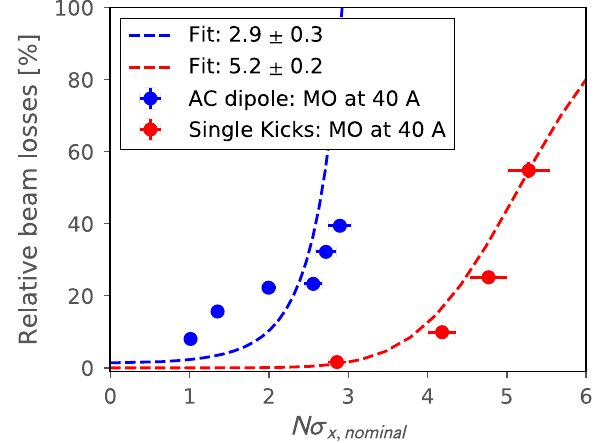
FIG. 16. Measured losses for both free kicks (red) and ac dipole excitations (blue) in the horizontal plane with Landau octupoles powered at 40 A. The blue fit is done with Eq. (14), while the red fit is done with the error-function of [40].